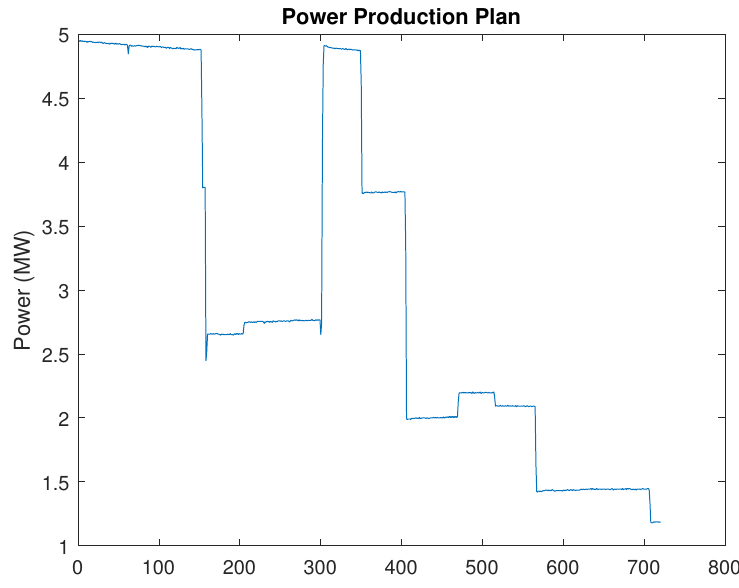
Figure 3. Historical power production plan during the simulation